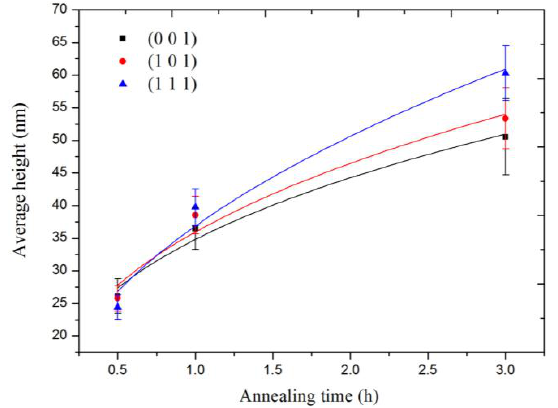
Figure 5. The height h of the nanocones on the irradiated tungsten surface with (0 0 1), (1 0 1) and (1 1 1) crystal orientations vs. annealing